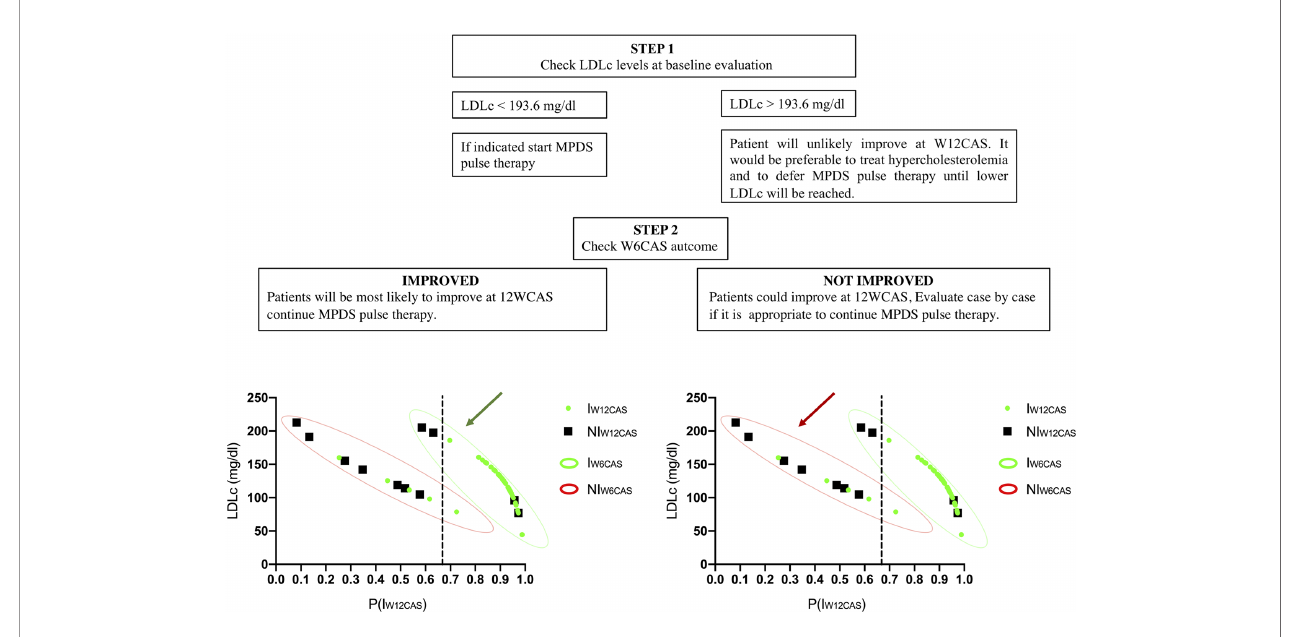
FIGURE 4 | Steps of the decision-making algorithm.